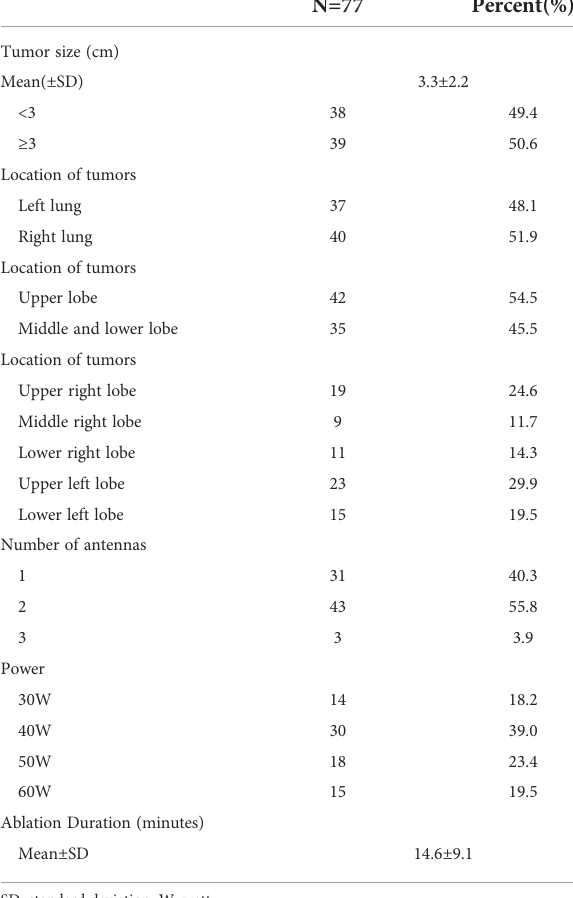
TABLE 2 Baseline characteristics of the tumors underwent